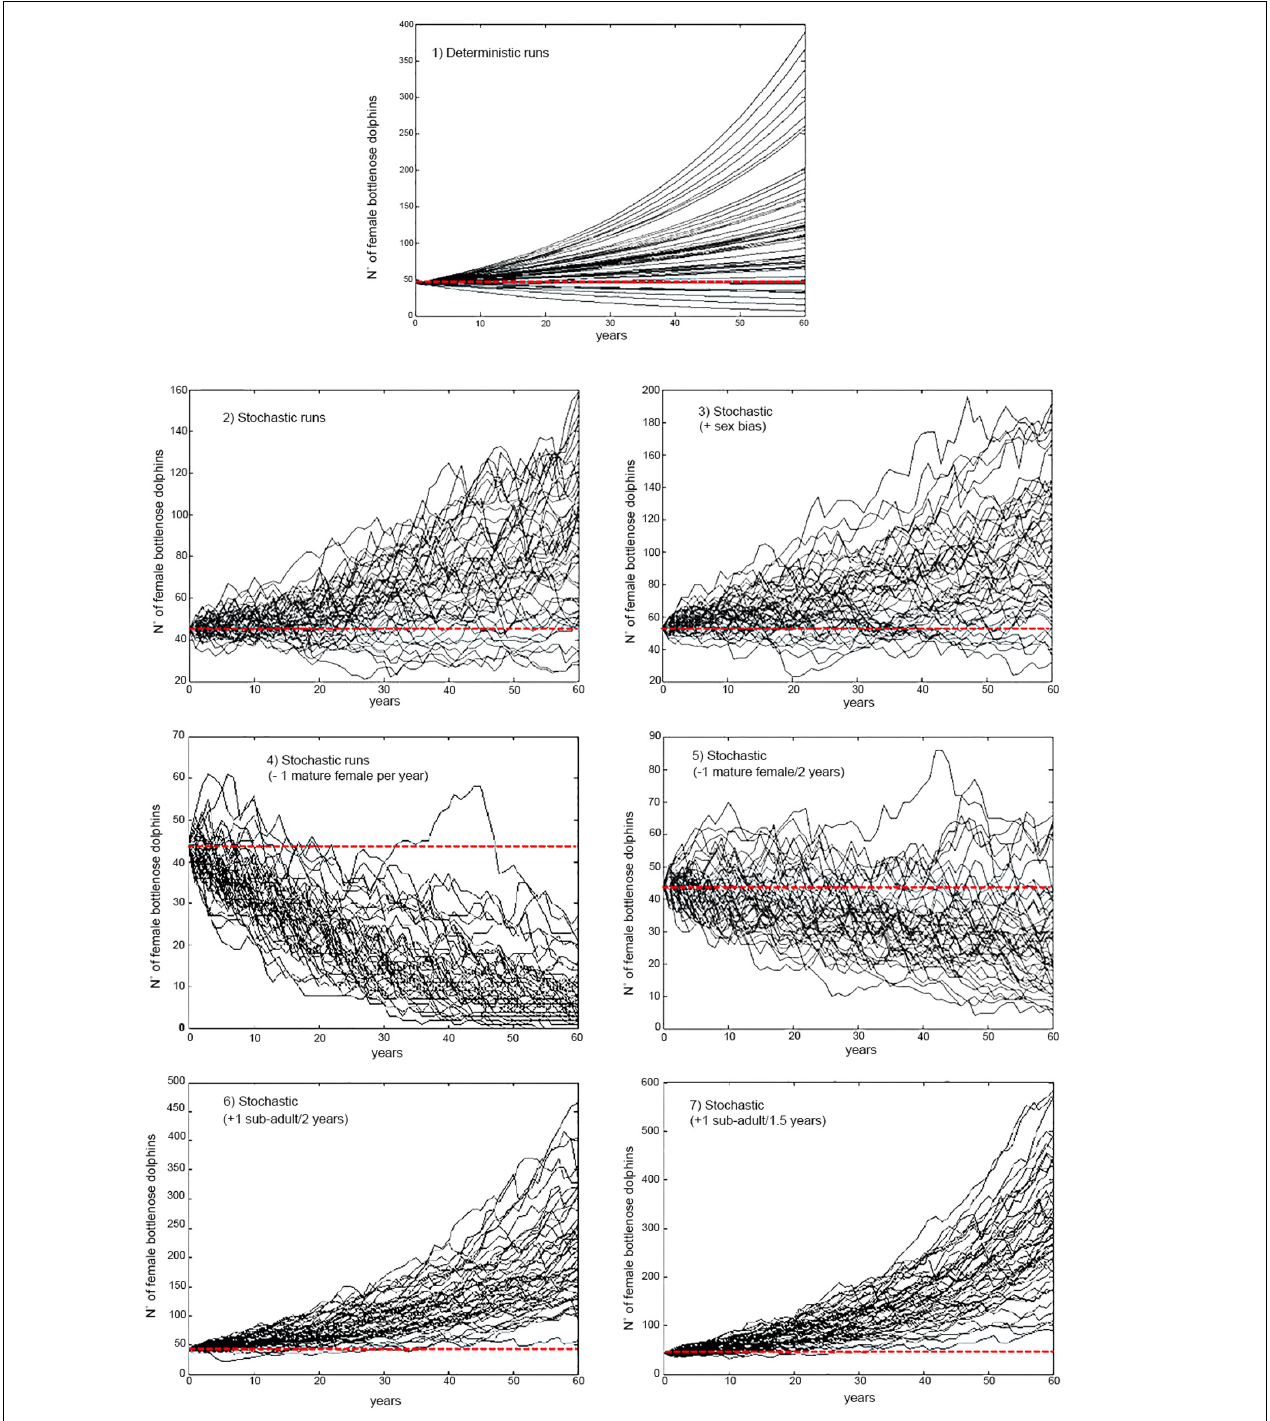
FIGURE 3 | Samples ( n = 50) from 1000 projections of the size of the resident population of bottlenose dolphin of the Patos Lagoon estuary for a period of three generations under different scenarios of by-catch and initial size considering parameter uncertainty in the estimates of stochastic population growth rate. Red dotted line highlights the initial female population size. Scenario 1 : Deterministic under current levels of by-catch; Scenario 2 : Stochastic under current levels of by-catch; Scenario 3 : Stochastic under current levels of by-catch and unbalanced adult sex ratio; Scenario 4 : Decreasing survival; removal of one mature female per year from the Patos Lagoon estuary’s dolphin population; Scenario 5 : Decreasing survival; removing one mature female every 2 years from the dolphin population; Scenario 6: Increasing survival; avoiding the bycatch of one juvenile from the dolphin population every 2 years; Scenario 7: Increasing survival; avoiding the bycatch of two juveniles from the dolphin population every 3